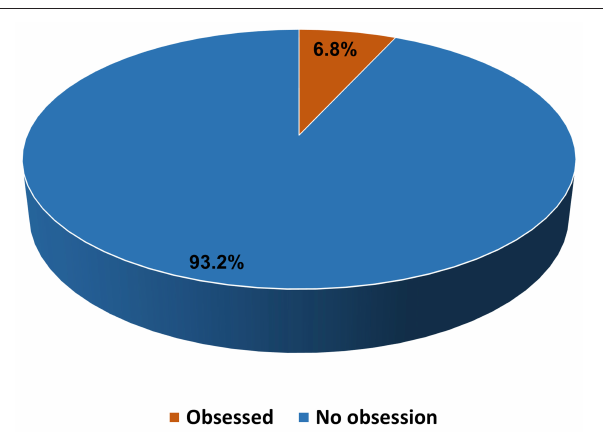
FIGURE 2 | Self-reported obsession toward the COVID-19 preventive measures among undergraduate medical students.